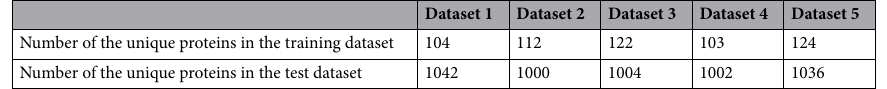
Table 1. The number of unique proteins in the training and test datasets for each split.